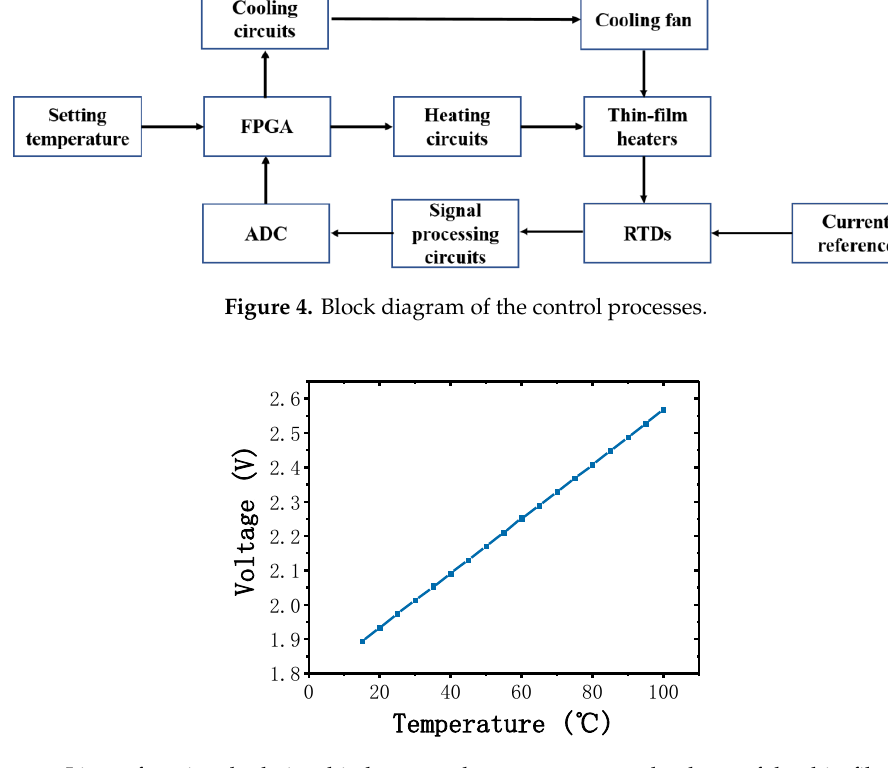
Figure 5. Linear functional relationship between the temperature and voltage of the thin-film heater.